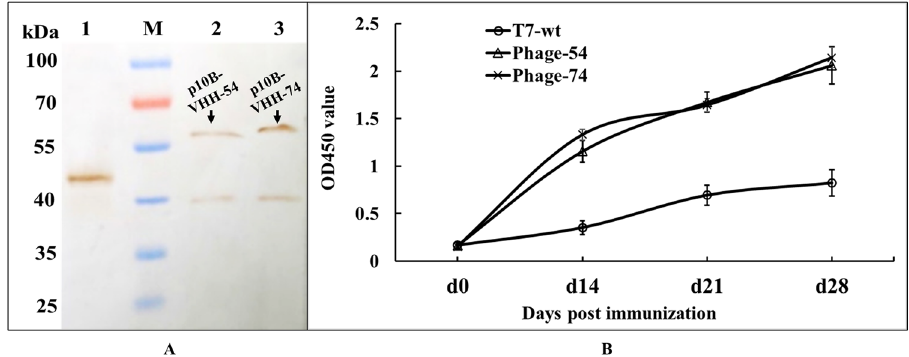
Figure 6. Detection of serum anti-p10B antibodies. ( A ) T7-wt, phage-54 and phage-74 were amplified, purified, and detected by Western-blot. Lane M: Pre-stained protein molecular weight marker (10 to 180